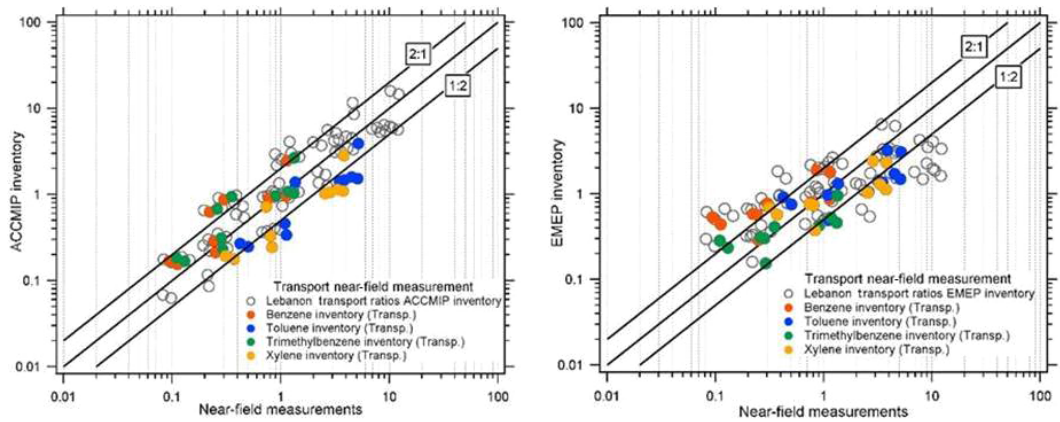
Figure 11. Comparison of the emission ratios of NMVOC vs. NMVOCi from ACCMIP and EMEP with the ER from near-field measurements for the road transport sector, for all data (in grey dots) and for a given NMVOC (coloured dots).